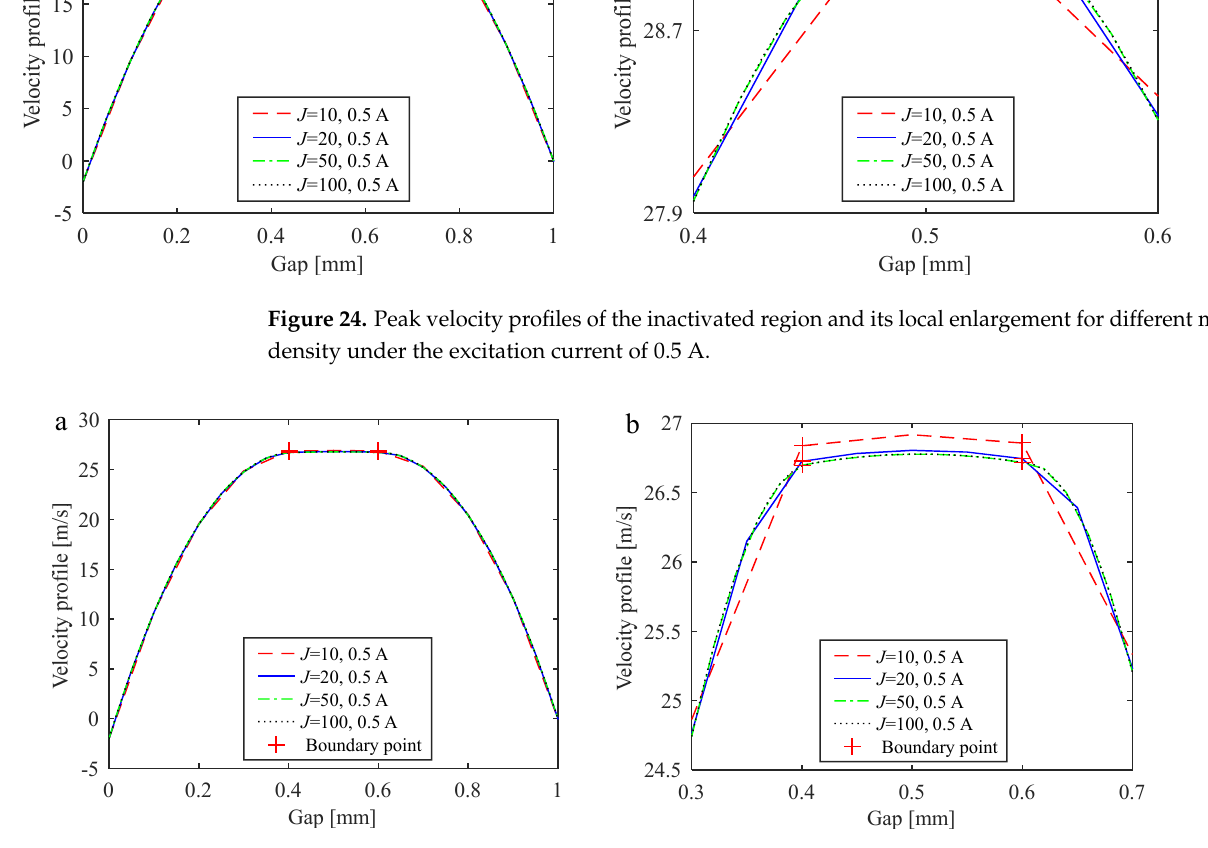
Figure 25. Peak velocity profiles of the activated region and its local enlargement for different mesh density under the excitation current of 0.5 A.